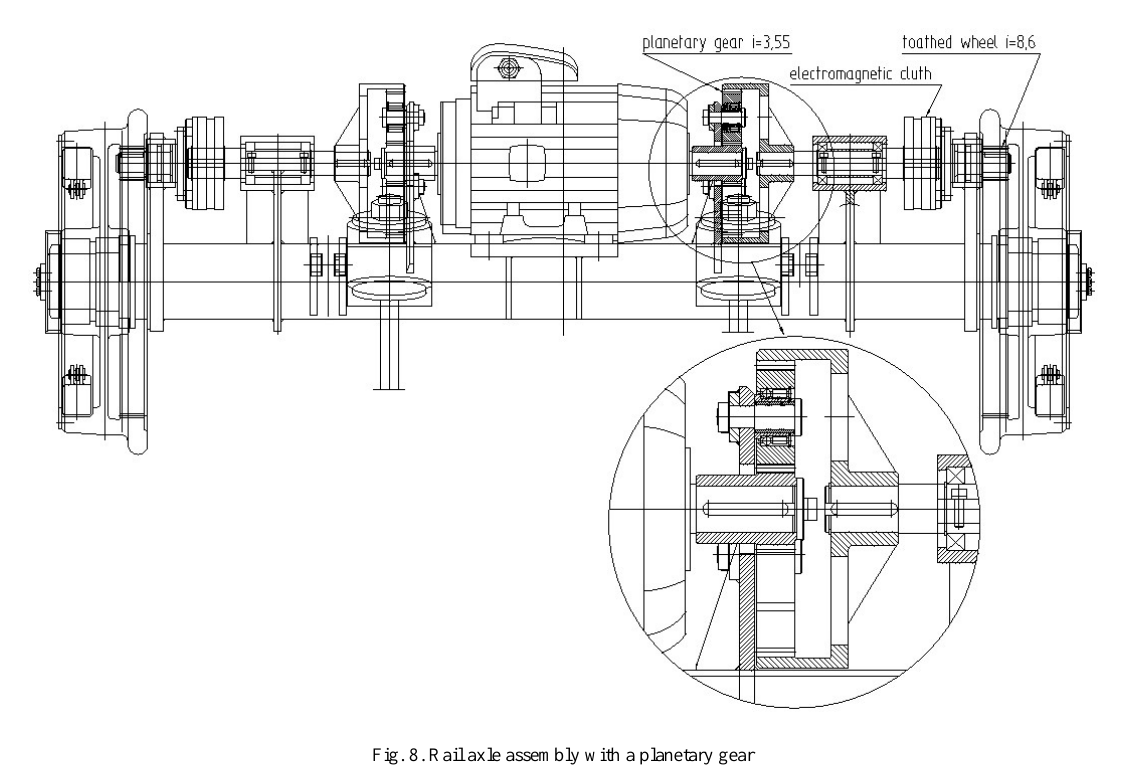
Fig. 8. Rail axle assembly with a planetary gear